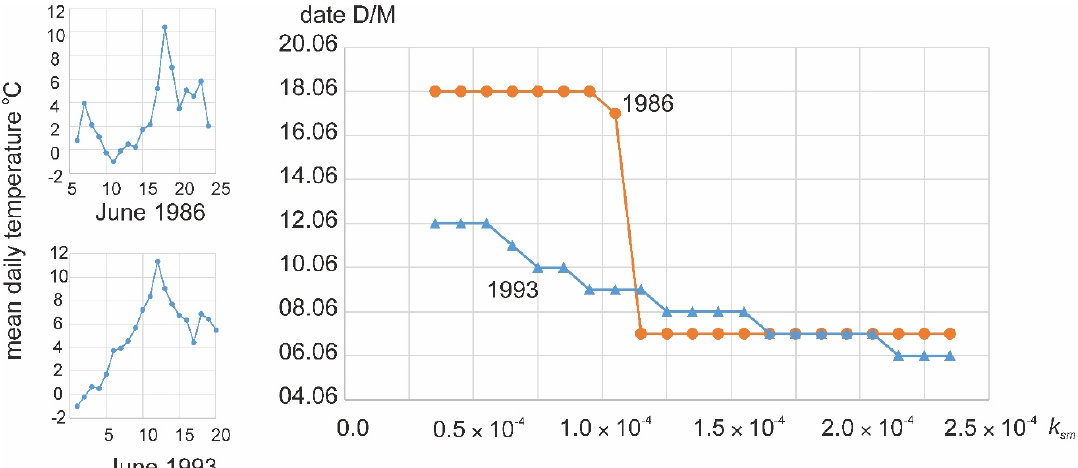
Figure 17. The differences in air temperature regimen during the snow thaw period and associated types of respond of timing of maximum X s_max to an increase of k sm . For details, see the text. The coefficient of water freezing k f was changed in the range 1.85 × 10 −6 ~−3.7 × 10 −5 . To this rather broad range corresponds the narrow range of X s_max 46.7–49.9 mm, so calculations with the model dampened the C v of k f = 0.56 to C v of X s_max = 0.02. The variability of parameters dropped to almost zero. In the calculation, the timing of X s_max was stable for 28 years of 35. It changed within 1–4 days with displacement of X s _ max to the later date in the years with the first type of temperature change regimen. In the years with the second type of temperature changes, an abrupt shift for 6–16 days to the later date can occur.